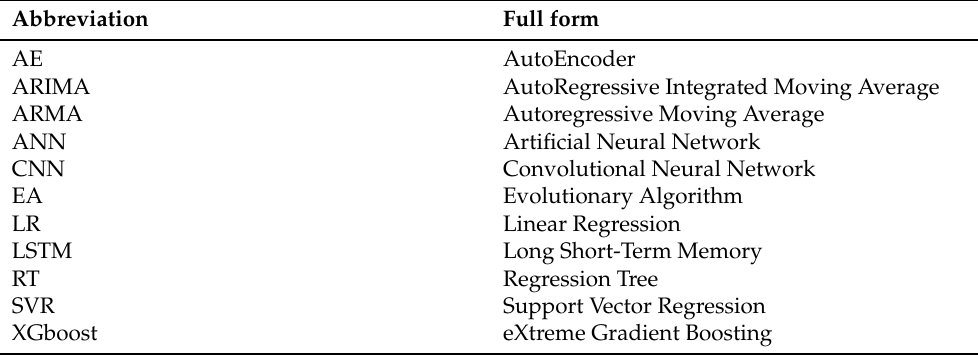
Table 1. List of abbreviations . The abbreviations including in the text are reported alphabetically.